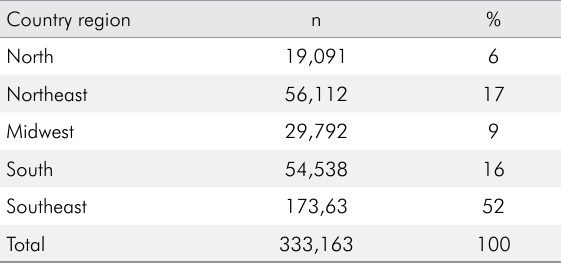
Table 2. Distribution of dentists in each region of the